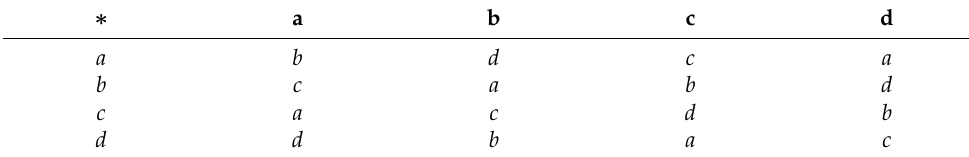
Table 9. This is an L3-transposition regular